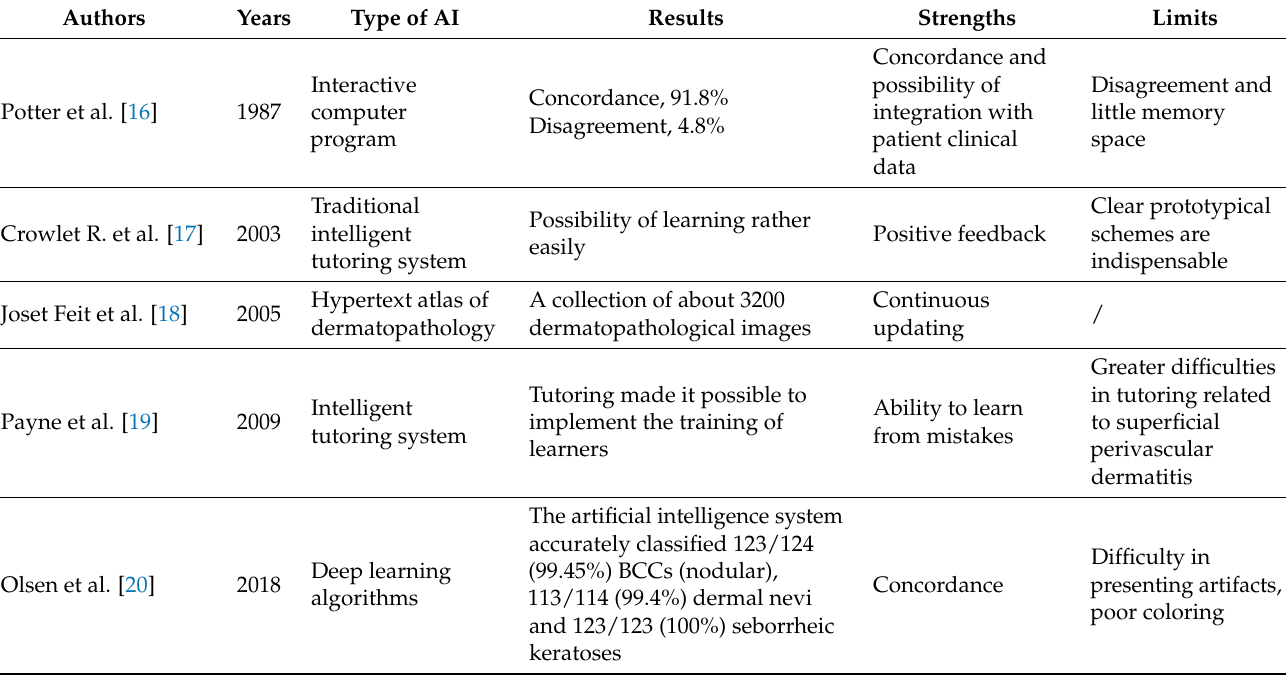
Table 1. Other studies present in the literature besides those analyzed in the Discussion section of this